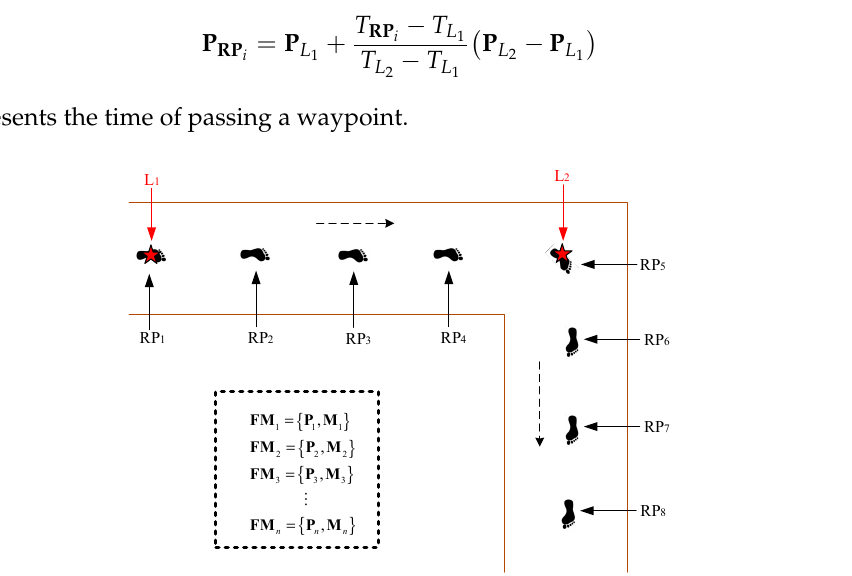
Figure 3. The procedure of training the magnetic map via a walking survey.